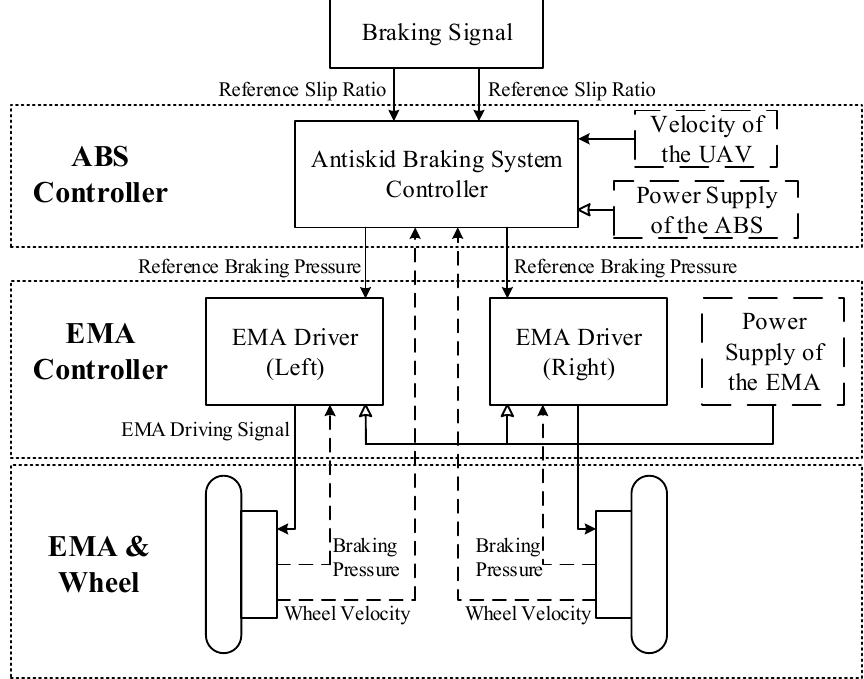
Figure 1. Control structure of the UAV antiskid braking system.